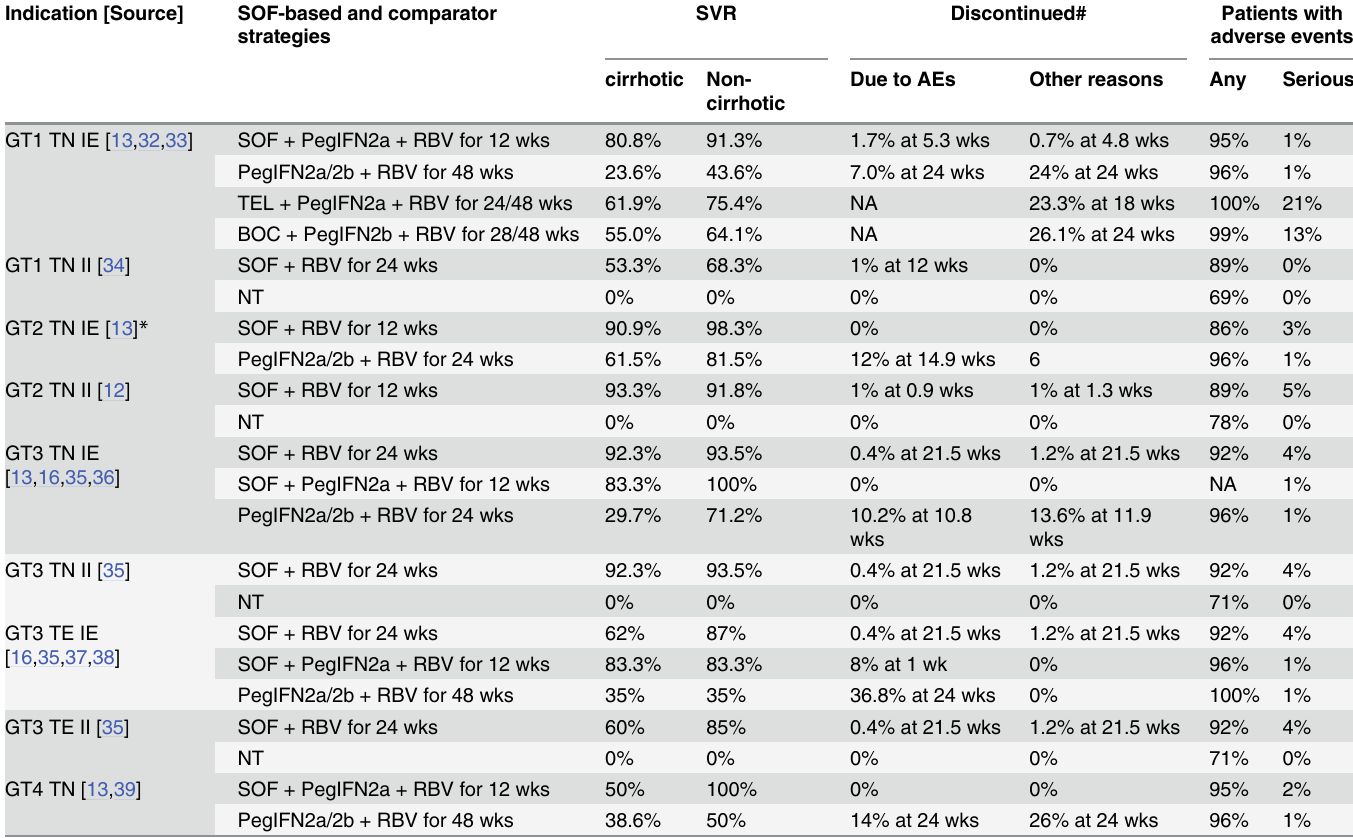
Table 2. Genotype-specific parameters including treatment efficacy, duration and safety. Indication